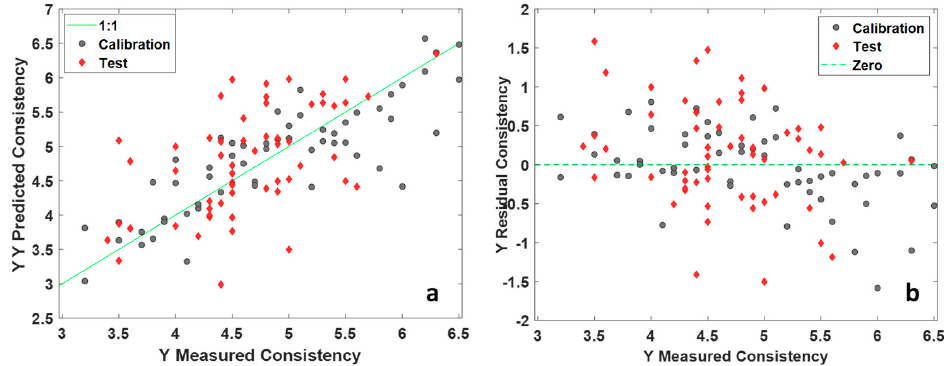
Figure 5. PLS results on NIR data for consistency. Predicted vs. measured values plot ( a ), residuals vs. measured values plot ( b ).